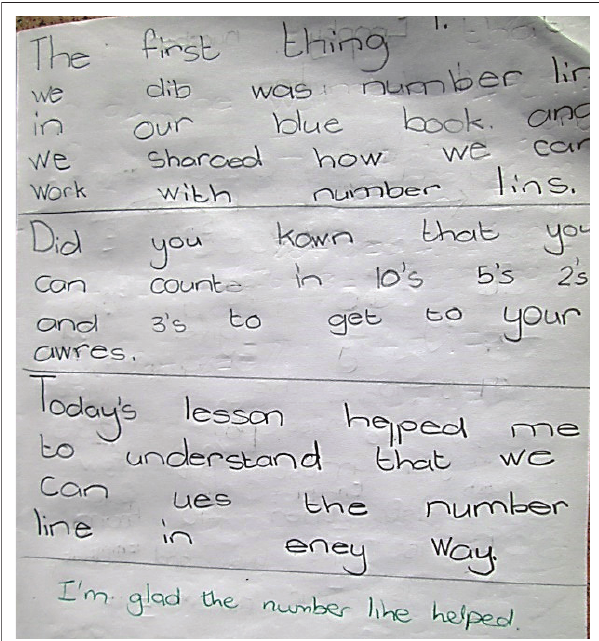
FIGURE 1: Kayla (Journal).